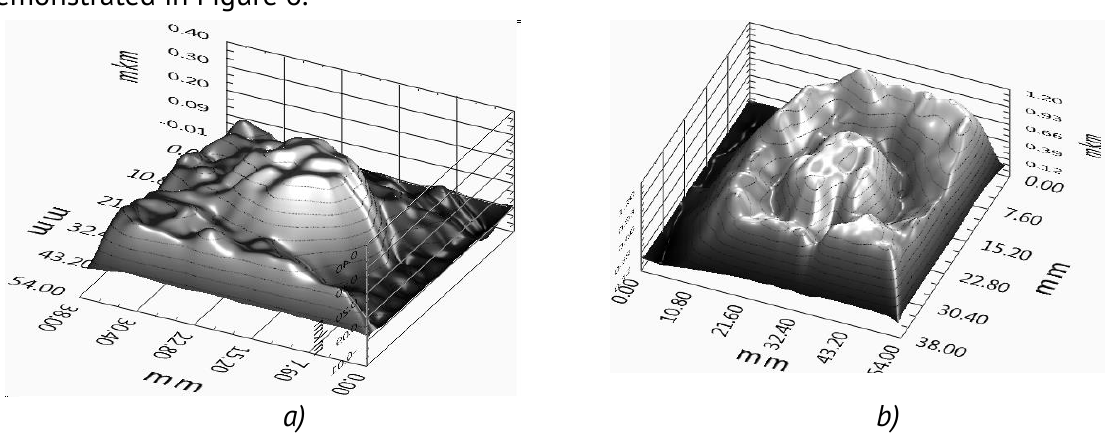
Figure 6. Deformation profile of the composite filled with a - cement, b - epoxy resin of a metal cylinder (Figure